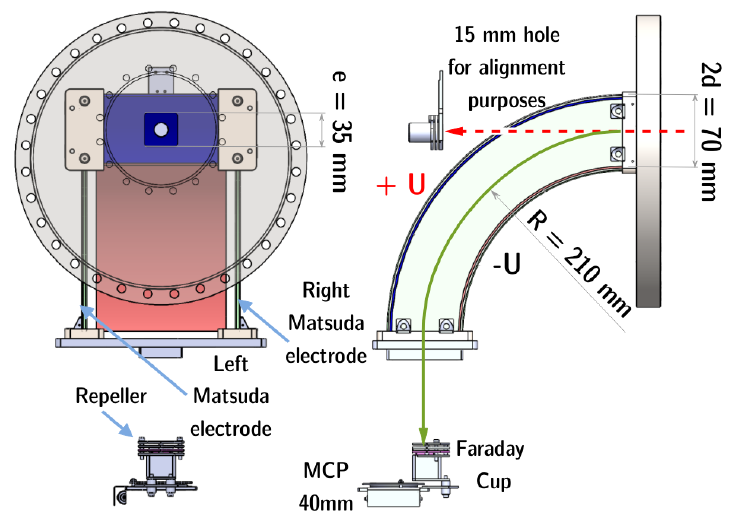
Figure 1. ( Left ) Front view of the spectrometer showing the entrance square with side e = 35 mm. ( Right ) Schematic cut through the ion spectrometer (side view). The expected ion trajectories for V = 10 kV and q = q 0 corresponding to U = 3333 V, and with U = 0 V (for beam alignment purposes) are